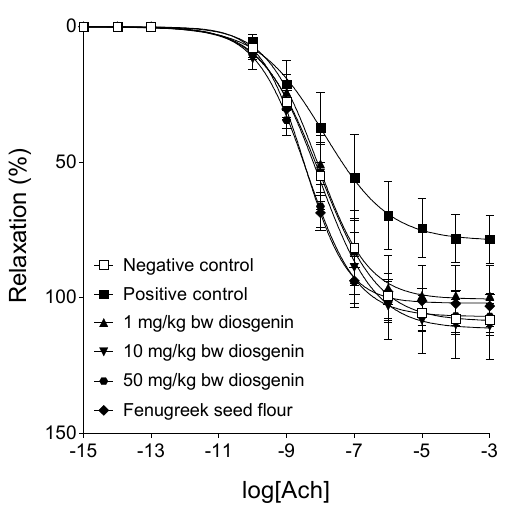
Figure A1. The relationship between the concentration of acetylcholine (Ach) and the NO-mediated (so-called endothelium-dependent) arterial relaxation in experimental groups subjected to different diets, created from real Ach concentration-response (E/c) curves presented on Figure 3. The axis x shows the common logarithm of molar concentration of Ach, and the axis y indicates the effect as a percentage decrease of the initial contractile force. The symbols show the modified effect values averaged within the groups ( ± SEM), and the lines denote the Hill equation fitted to the averaged modified Ach E/c data.